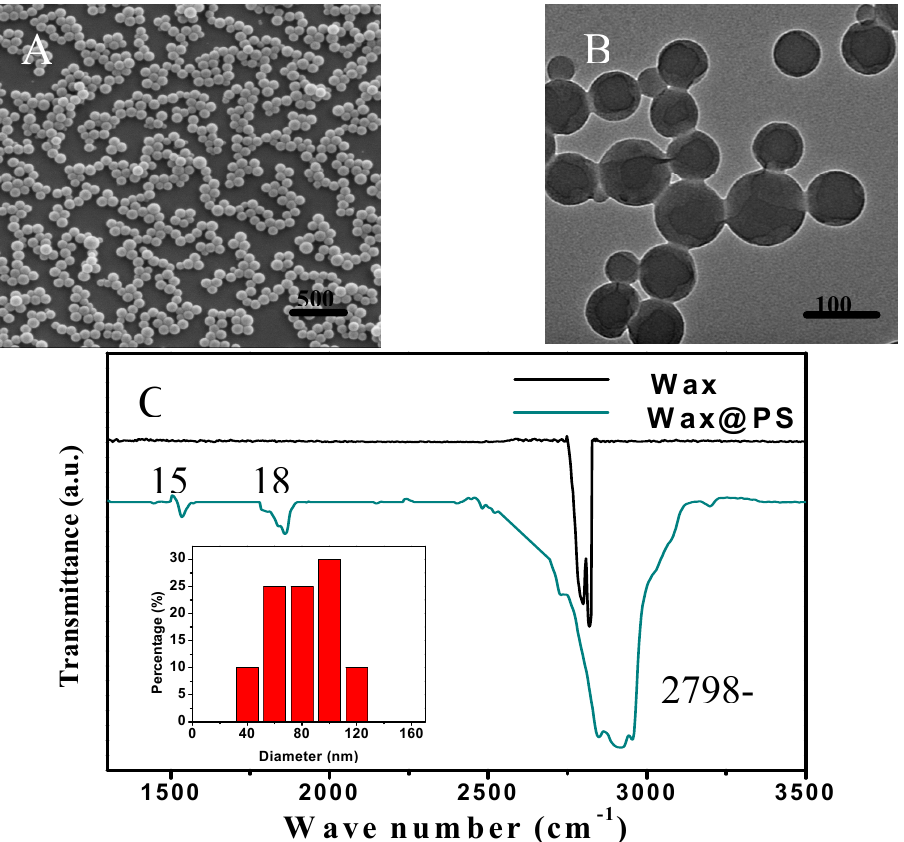
Figure 2. ( A ) Scanning electron microscope (SEM) and ( B ) transmission electron microscope (TEM) images of polymer encapsulated nanoparticles. ( C ) Fourier Transform infrared spectrometer (FTIR) spectra of paraffin (1) and polymer-encapsulated